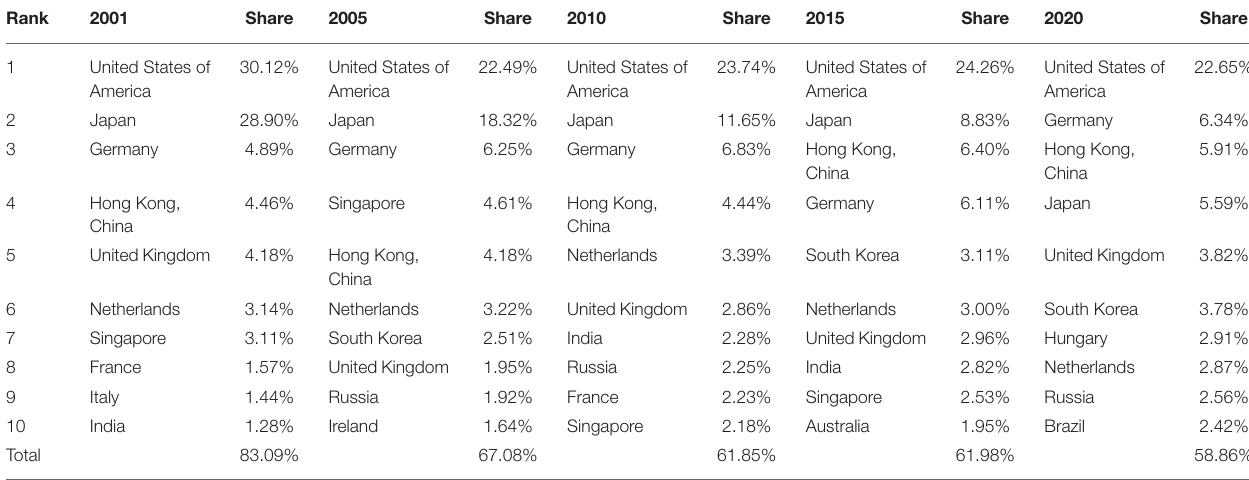
TABLE 5 | Changes in China’s major export markets for medical devices and their shares. Rank United States of